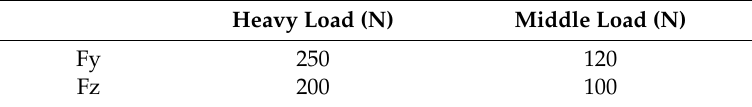
Figure 3. Finite element model of the cantilever beam. Table 1. Loading types and directions on free-end.